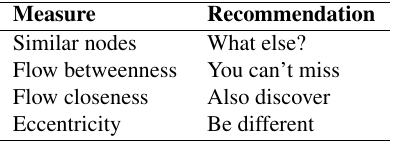
Table 1: Centrality-based recommendations.